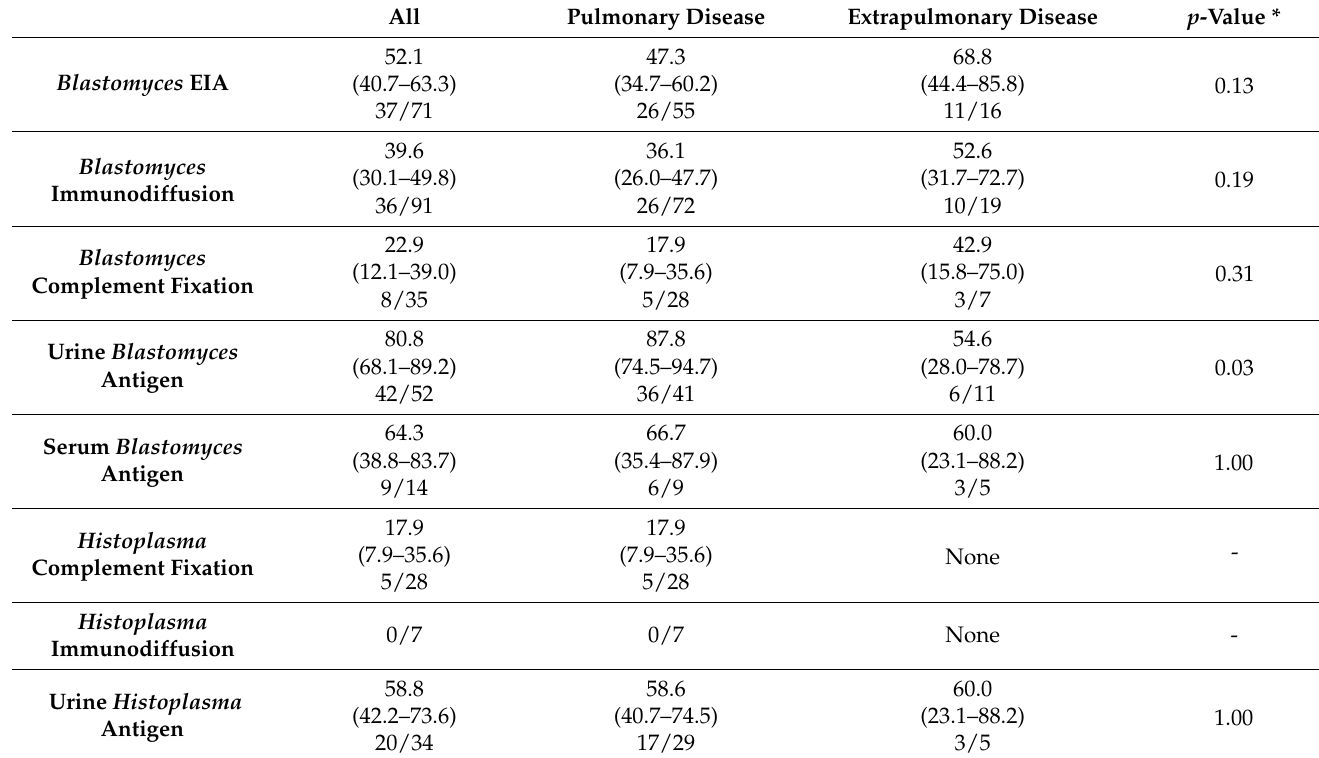
Table 5. Sensitivity of diagnostic assays in patients with disease confirmed by culture and/or histopathology with comparison between pulmonary and extrapulmonary disease. All Pulmonary Disease